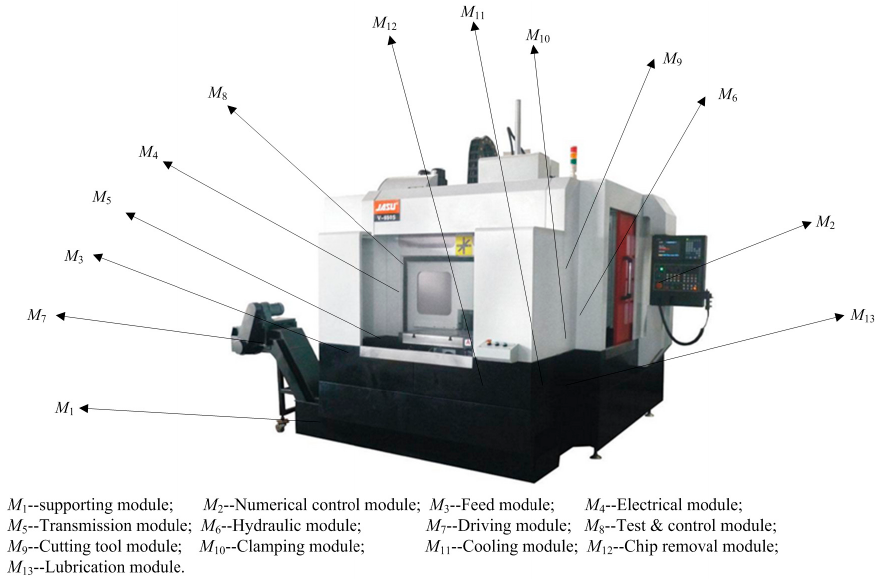
Figure 3. Function modules of the computer numerically controlled (CNC) machine tool.